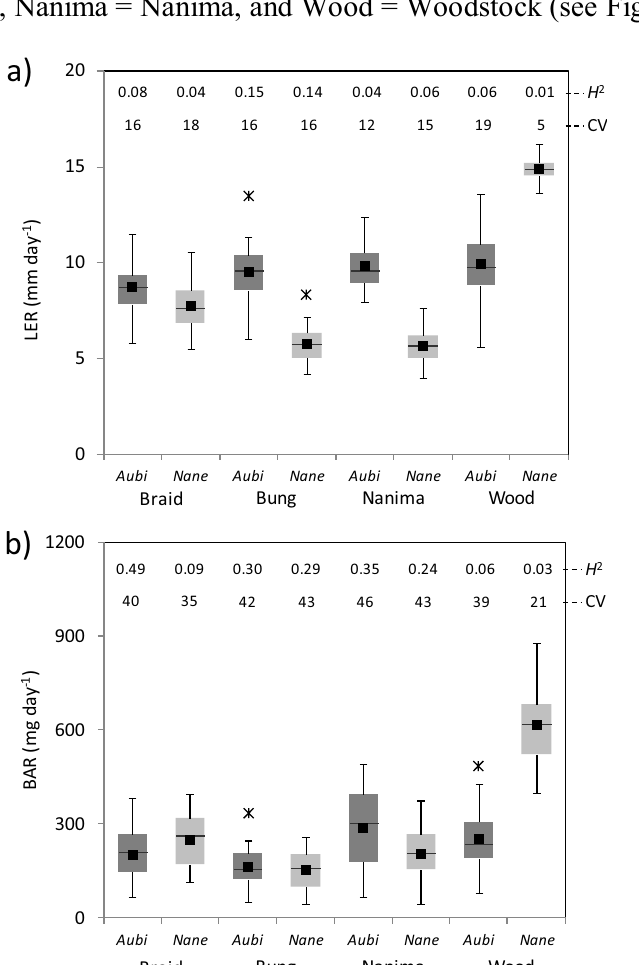
Figure 5. Boxplots showing growth of A. bigeniculata and N. neesiana tussocks during Phase I of the experiment. ( a ) Leaf elongation rate (LER) in February 2011. ( b ) Biomass accumulation rate (BAR) during February (cid:177) April 2011. Data are based on estimated means for each clone line (n = 24) within each of the eight plant populations (four A. bigeniculata and four N. neesiana populations). Numbers at the top of each panel are the broad sense heritability ( H 2 ) and the coefficient of variation (CV; expressed as a percentage of the mean) of the trait across clone lines (see methods). For species names, Aubi = Austrostipa bigeniculata and Nane = Nassella neesiana . For site names, Braid = Braidwood, Bung = Bungendore, Nanima = Nanima, and Wood = Woodstock (see Figure